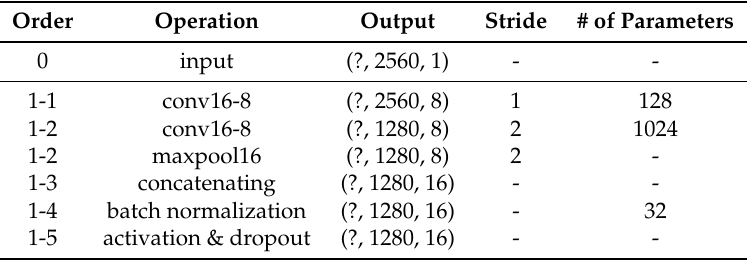
Table A1. More detailed information about the proposed architecture. “conv” denotes “conv(filter width)-(filter channel)”. Similar to “conv”, “maxpool16” refers to max pooling with 16 lengths of the